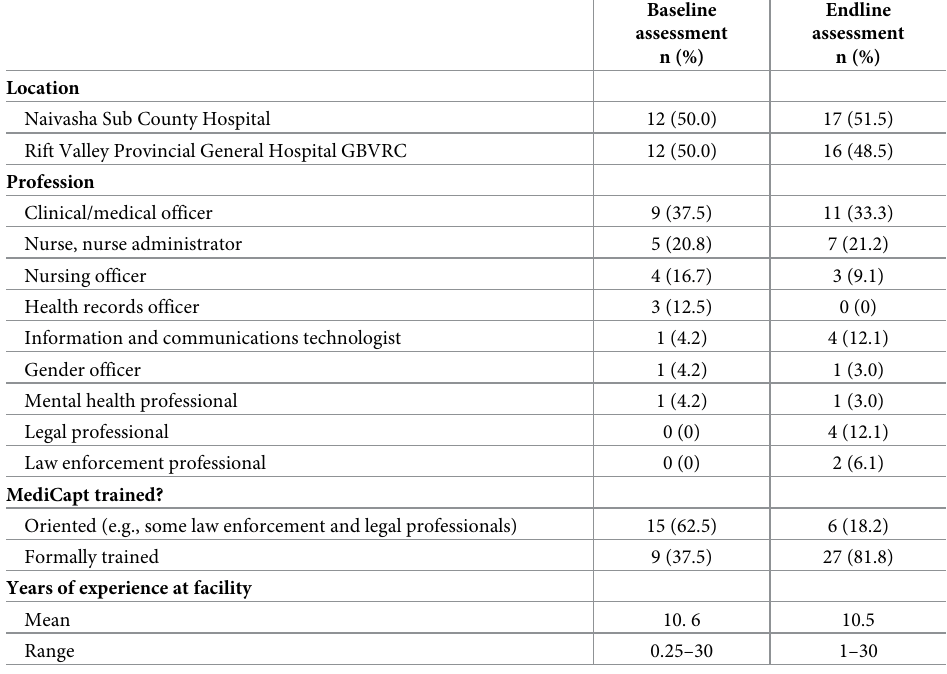
Table 3. Semi-structured interview participants conducted during the baseline (N = 24) and endline (N = 33)